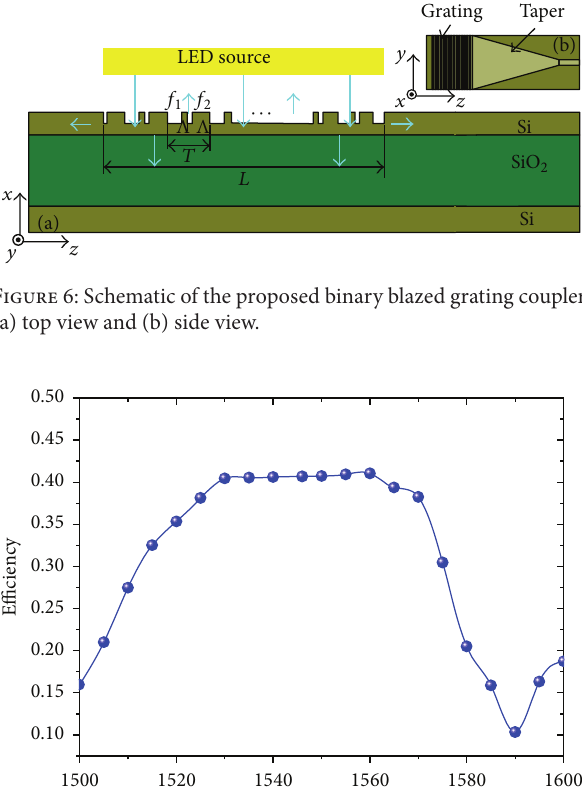
Figure 9: Light incident angle and coupling